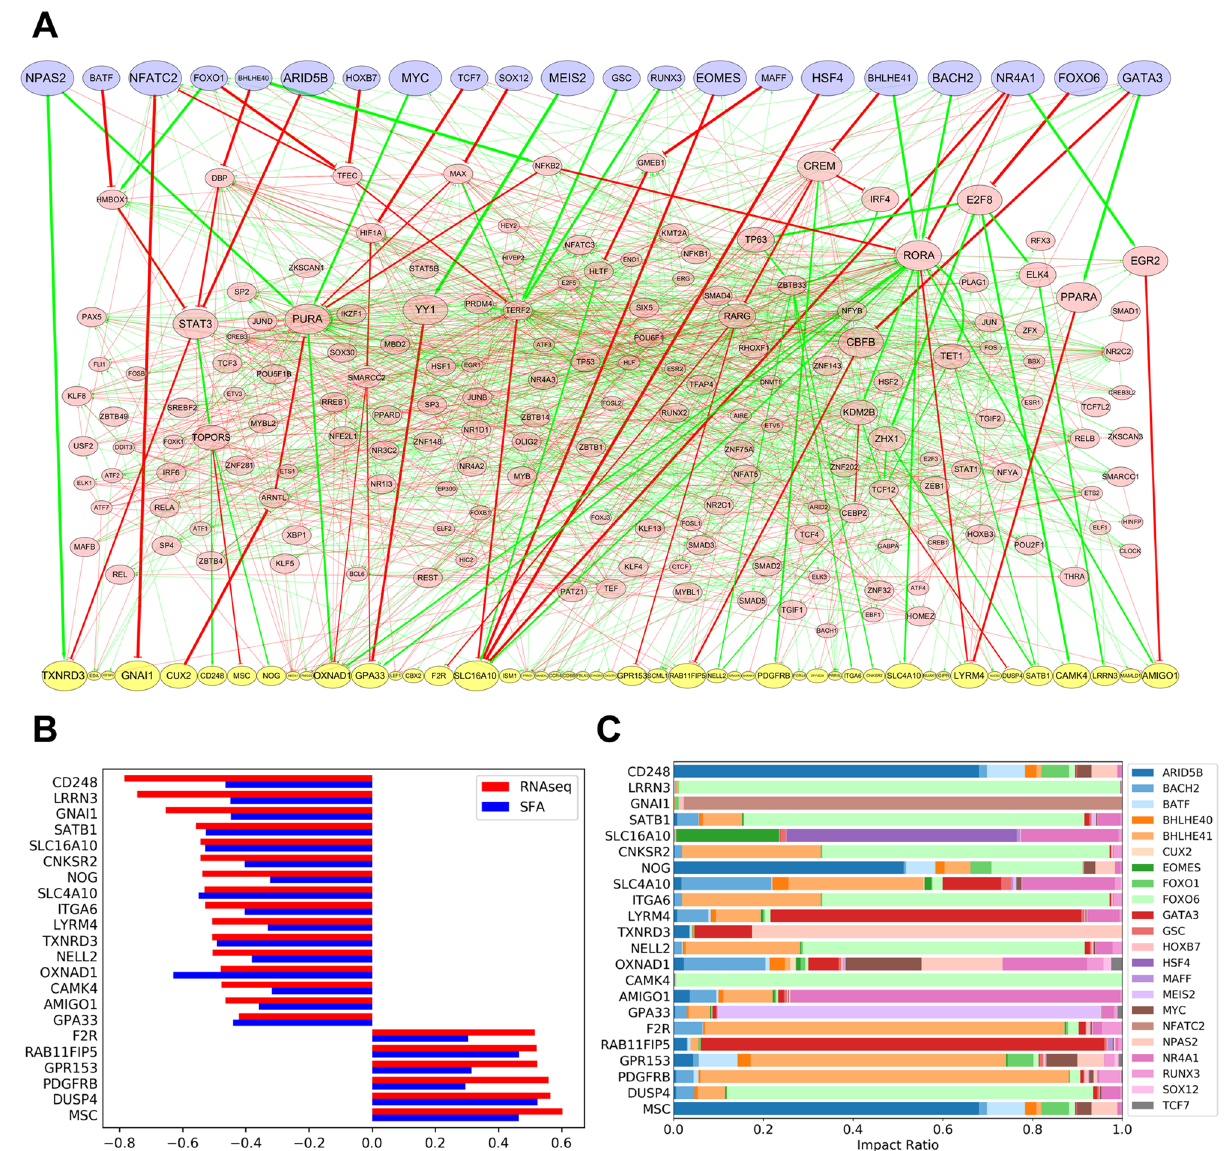
Figure 3. Signal flow analysis of the aging-related GRN constructed with 22 DMP markers and 46 DEG markers. ( A ) Methylation changes during aging were considered as initial signals for visualization of the aging- related GRN. An increase in edge thickness and node size is based on the intensity of the signal transmitted to the DEG markers via the network. DMP input nodes are indicated in blue; DEG output nodes are indicated in yellow; edges representing up-regulated and down-regulated TG expression are indicated in green and red, respectively. ( B ) The direction of activity change (DAC) and aging-related fold change in RNA-seq analysis were consistent for the 22 output DEGs. ( C ) Relative influence of the 22 input DMPs on the DAC of the 22 output DEGs. SFA, signal flow